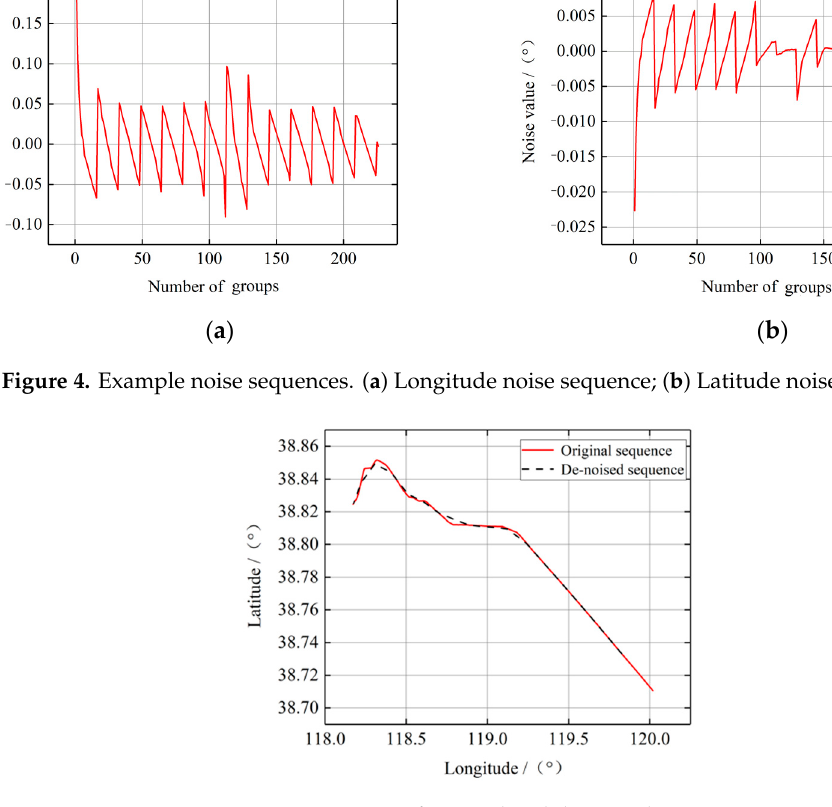
Figure 5. Comparison of original and de-noised sequences.